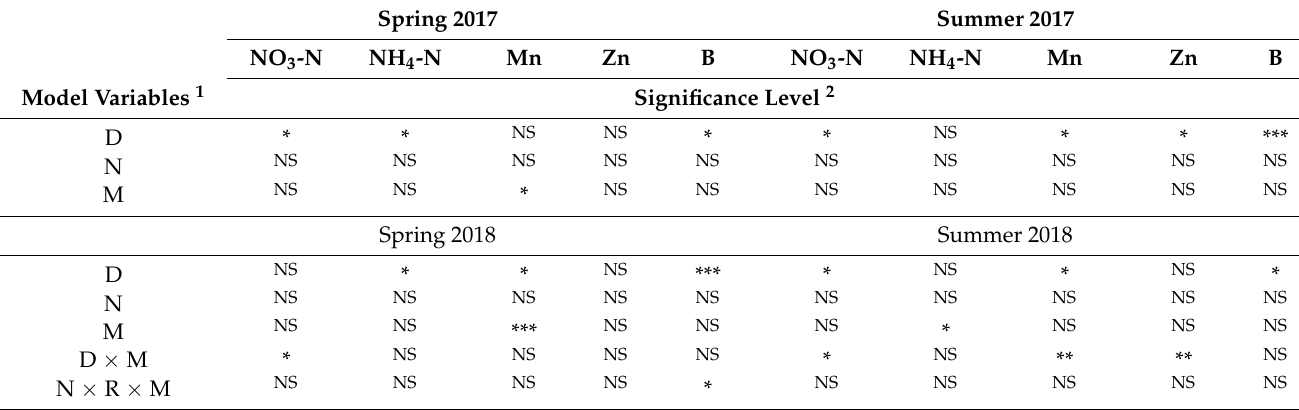
Table 2. Analysis of variance (ANOVA) of soil nutrient concentration on a dry weight basis under Huanglongbing-affected Valencia citrus trees at Immokalee, FL during 2017 and 2018 growing